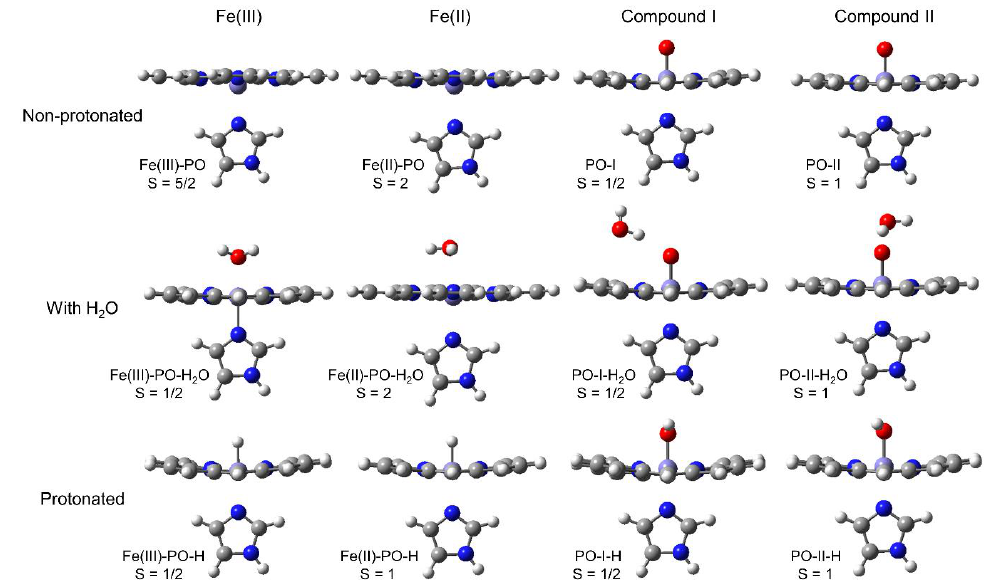
Figure 3. Structures optimised at the B3LYP/cc-pVDZ computational level for Fe(III) native perox- idase, ferrous species, compound I, and compound II at the most stable feasible spin state, either non-protonated, with a H 2 O discrete molecule, or protonated at a distal axial